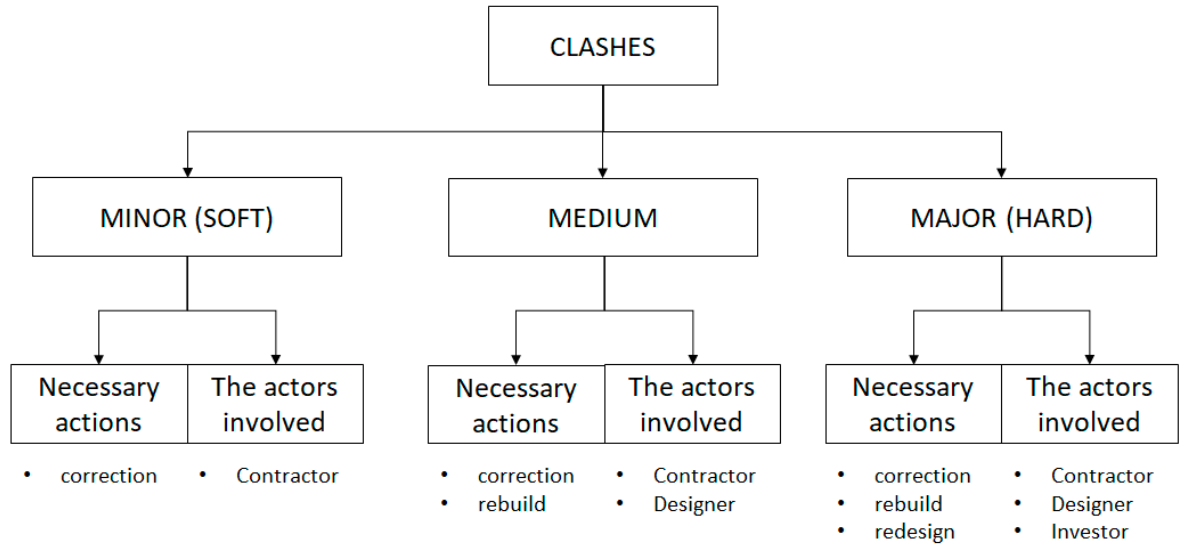
Figure 2. Types of clashes divided into minor (soft), medium and major (hard) .